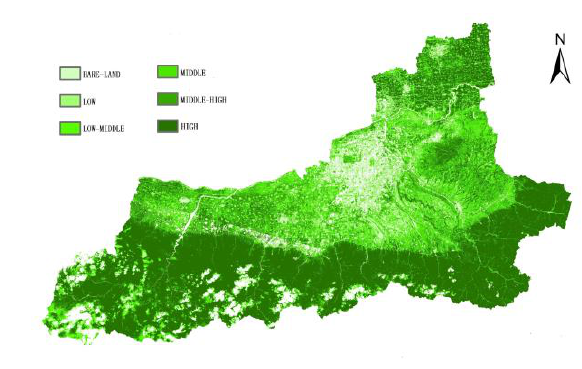
Figure 7. Spatial Distribution of Vegetation Coverage in